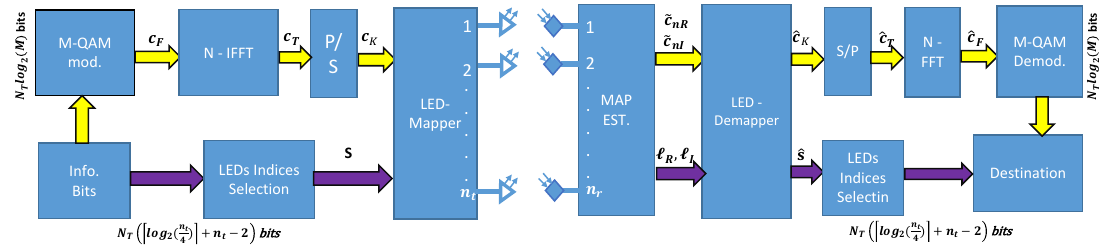
Figure 1. The extended spatial-index light emitting diode (ESI-LED) modulation system structure with n t × n r